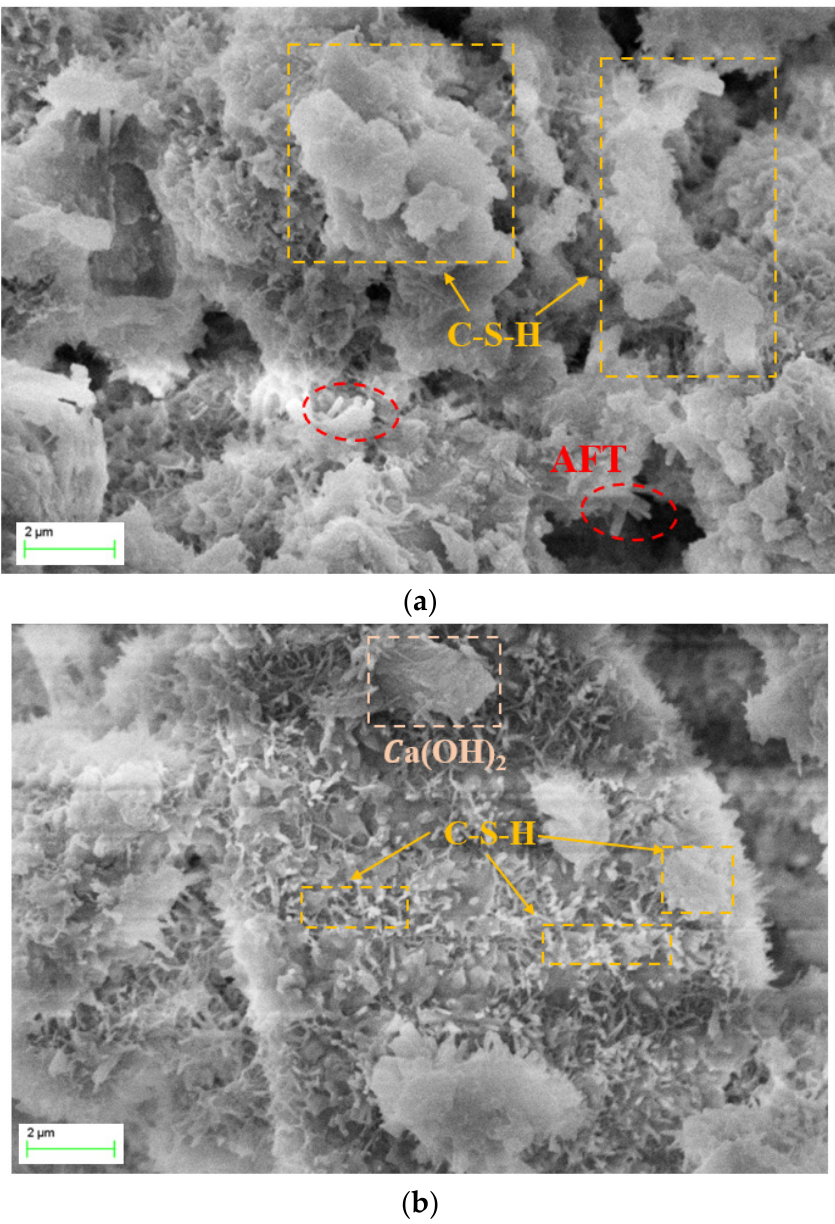
Figure 13. ITZ (limestone) SEM results (Group 6). ( a ) ITZ (limestone) scan result 1. ( b ) ITZ (limestone) scan result 2.